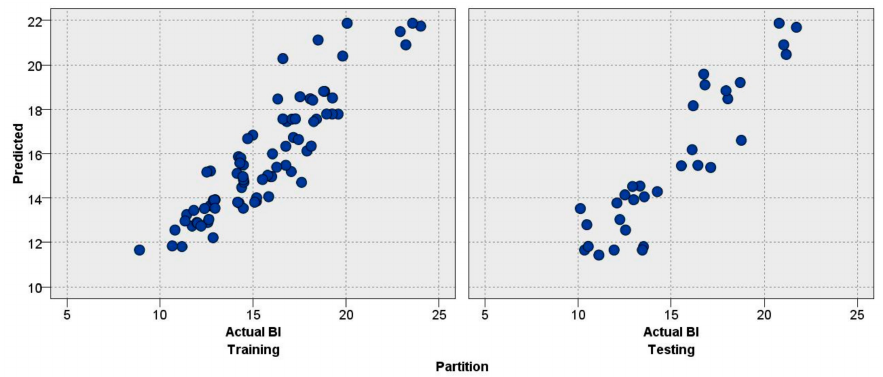
Figure 11. Testing and training results of KNN model to predict the BI .